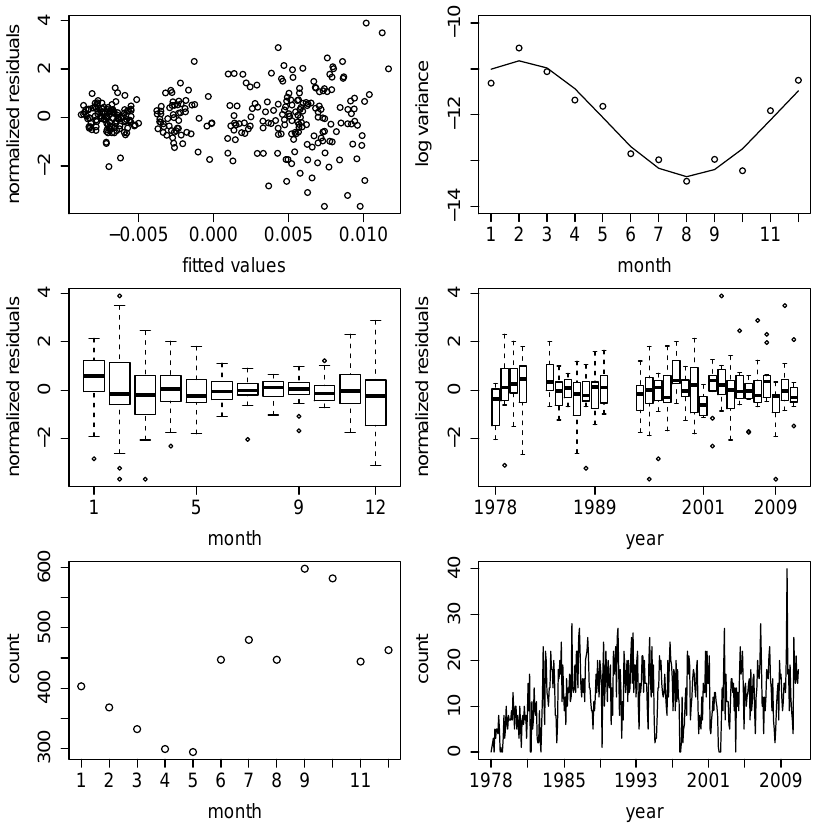
Fig. 4. Diagnostic plots of the regression model in Eq. (6) for PC score 1 of Boulder. Upper left panel: plot of normalized residuals versus fitted values. Upper right panel: log-variance of raw residuals computed for each month. The plots in the second row are box plots of normalized residuals grouped by month (left) and year (right). Bottom panels: counts of daily ozone observations per month (left) and year (right) as a time series.